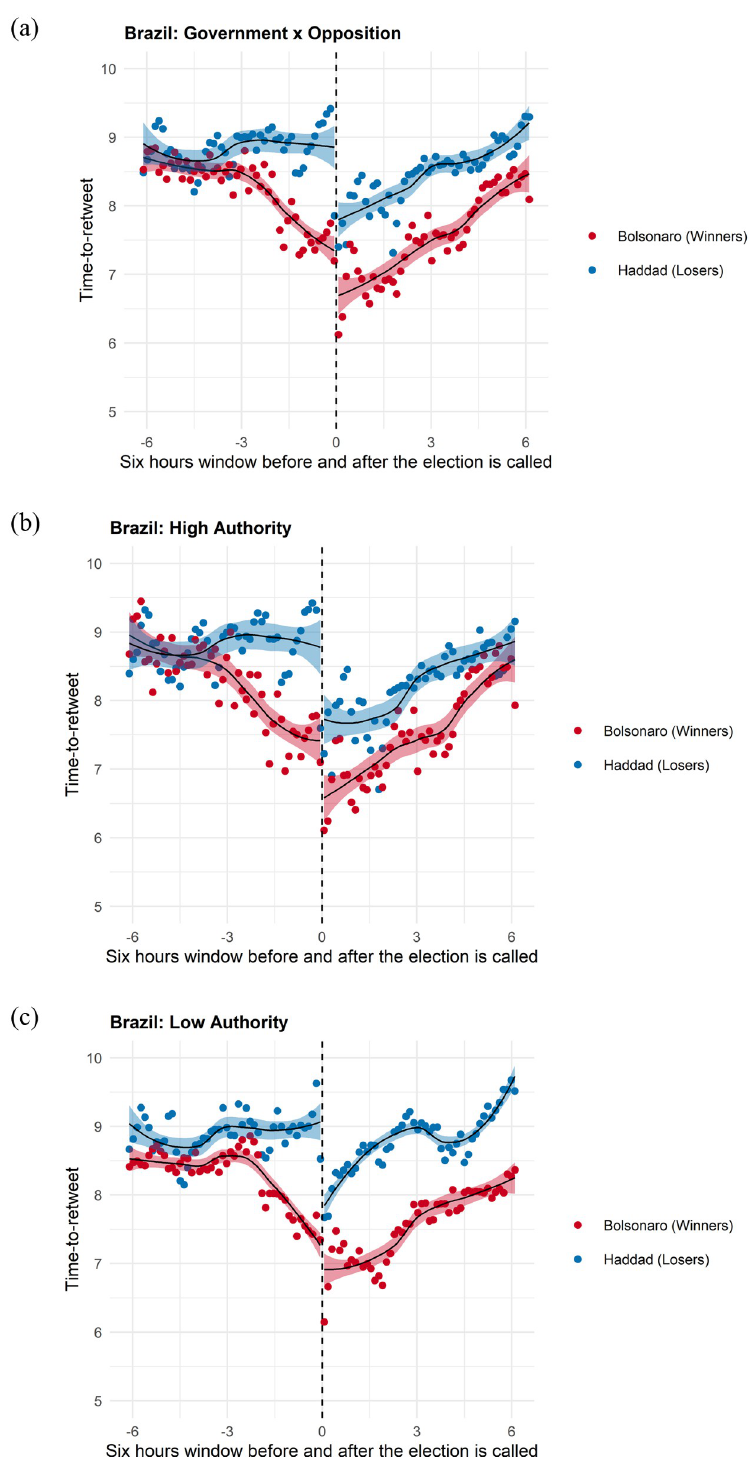
Fig 4. Time-to-Retweet in the Brazil Election. (a) Winners vs Losers, (b) High Authority Users, (c) Low Authority Users.